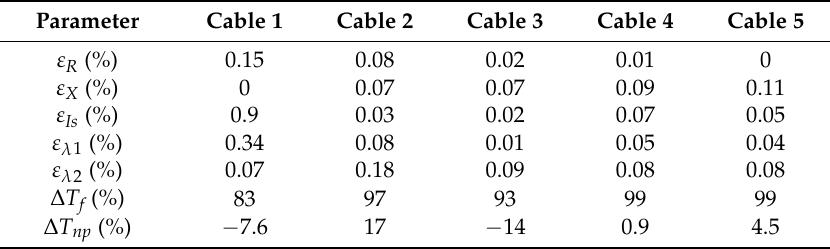
Table 3. Error in R , X , I s , λ 1 , λ 2 and simulation time reduction in short periodic model in relation to full periodic and non-periodic models with L = 1.25 CP